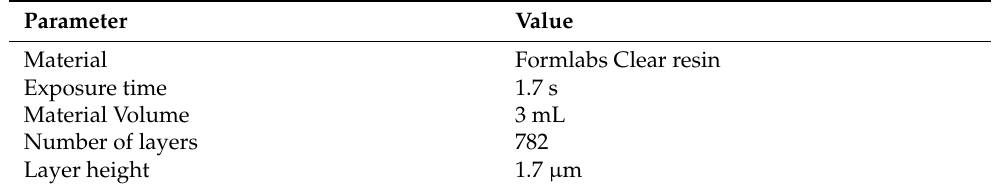
Figure 4. 3D model of the designed biomimetic leaf surface.